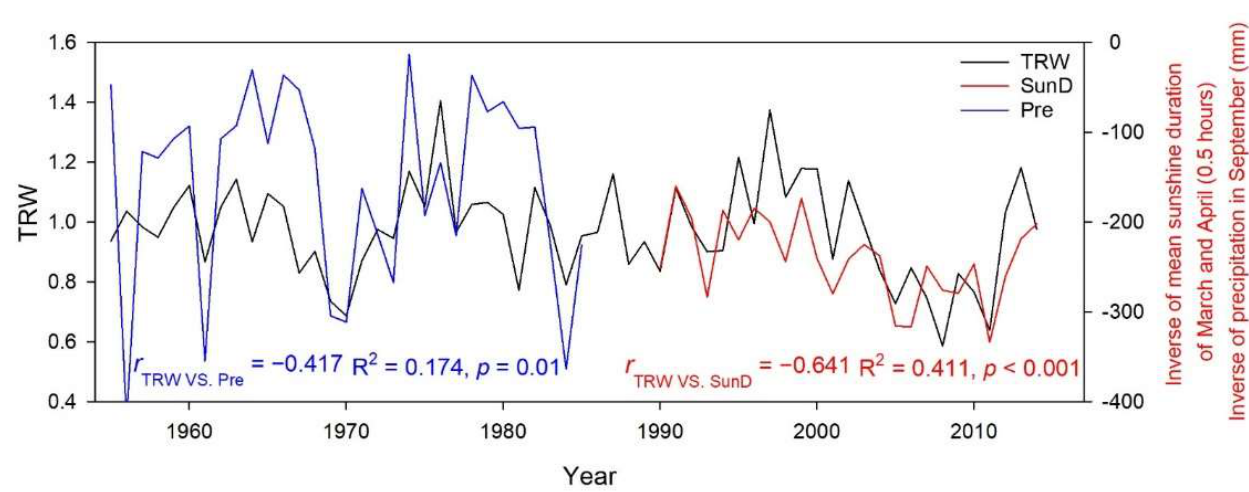
Figure 7. Best-fitted linear regression results. TRW, tree-ring width chronology; Pre, inverse of the precipitation in September; SunD, inverse of the mean sunshine duration of March and April. Table 1. Linear regressions between tree-ring chronology and climate factors (precipitation of Sep- tember and mean sunshine duration from March to April).